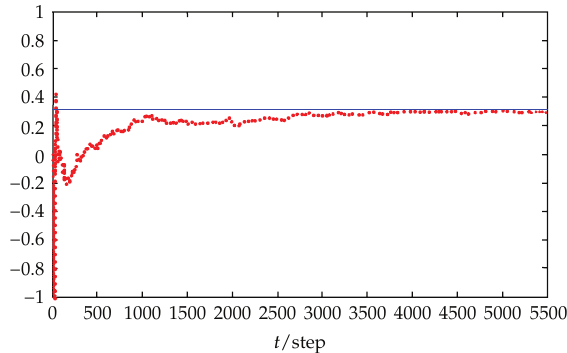
(cid:11) d (cid:5) t (cid:6) . 11